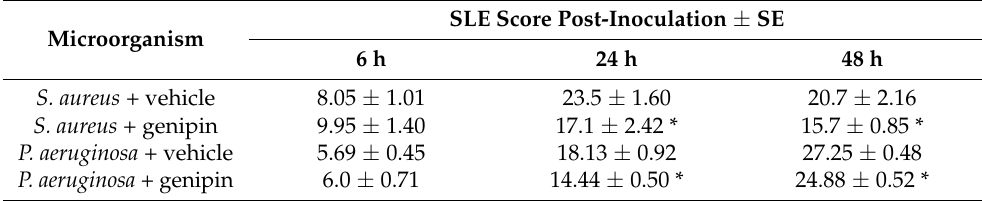
Table 1. Average slit-lamp examination (SLE) score at 6 h, 24 h, and 48 h of experimental groups ( n = 5 per experimental